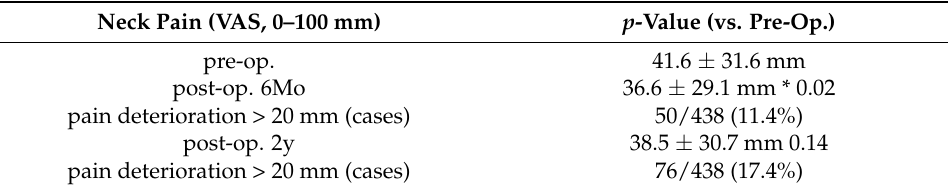
Table 2. Changes in VAS neck